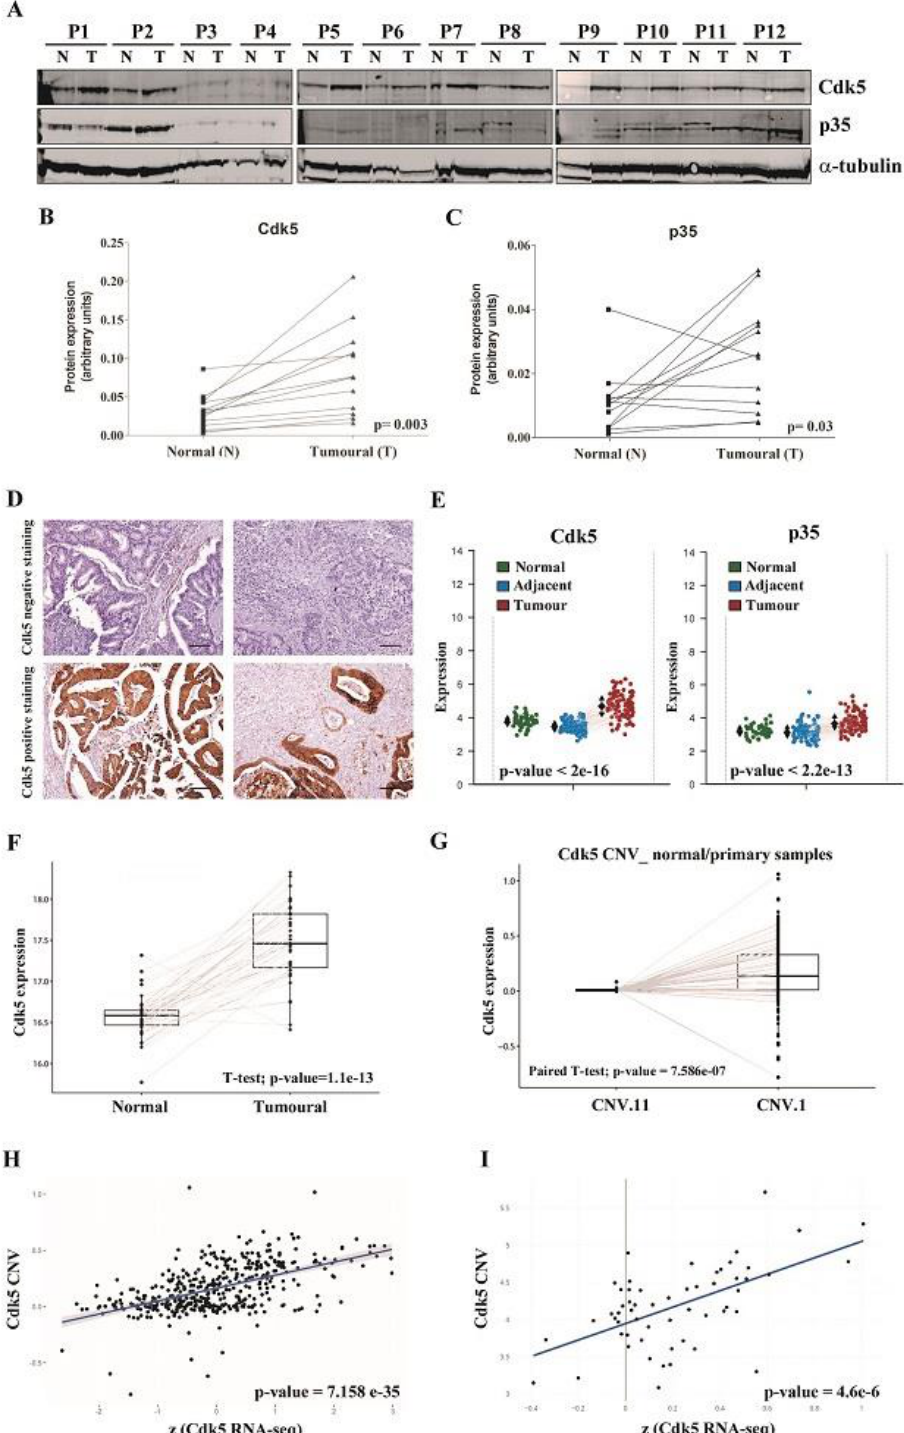
Figure 3. Cyclin dependent kinase (Cdk5) and p35 expression in colorectal cancer (CRC) tumor samples. Western blot ( A ) and graphic representation ( B , C ) of Cdk5 and p35 protein expression, respectively, in tumoral (T) and normal adjacent (N) tissues of 12 stage IV CRC patients (cohort A). Alpha-tubulin was used as endogenous control. The p -value was according to paired t -test. ( D ) Representative immunohistochemistry images of Cdk5 staining in CRC tumor tissues. The upper panel shows negative staining and lower panel positive staining. Scale bar: 100 µ m. ( E ) Graphic representation of Cdk5 and p35 mRNA expression in 98-paired adjacent normal and tumoral tissues from stage II microsatellite stable (MSS) CRC patients (cohort B). ( F ) Graphic representation of Cdk5 mRNA expression in normal and tumoral tissues of 38 I-IV CRC patients. Data were obtained from The Cancer Genome Atlas (TCGA) database (cohort F). ( G ) Graph representing the Cdk5 copy number (CNV) change between normal and tumoral tissues in 67 stage I – IV CRC patients (cohort F). ( H ) Correlation between Cdk5 CNV and Cdk5 gene expression in 429 stage I – IV CRC patients. p-value according to Pearson correlation test (cohort F). ( I ) Correlation between Cdk5 CNV and Cdk5 gene expression in 63 CRC cell lines. The p -value was according to Pearson correlation test. Data from the Broad Institute Cancer Cell Line Encyclopedia.